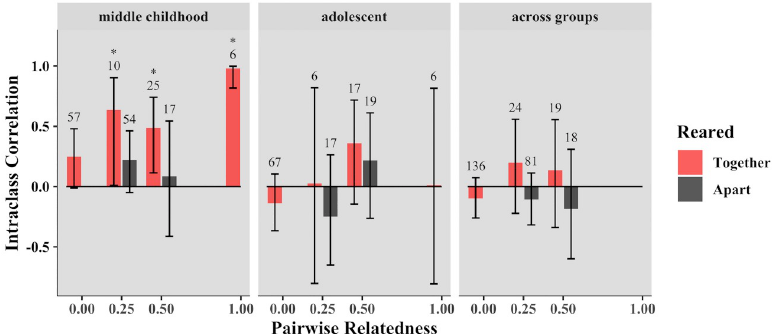
Fig 2. Intraclass correlations for BMI by age group. We observed a general trend of increasing correlation among BMI estimates of related pairs and those sharing a home in middle childhood sibling pairs. Number of pairs of each type are reported above each bar and correlations different from zero are marked with an asterisk ( p < 0.05).